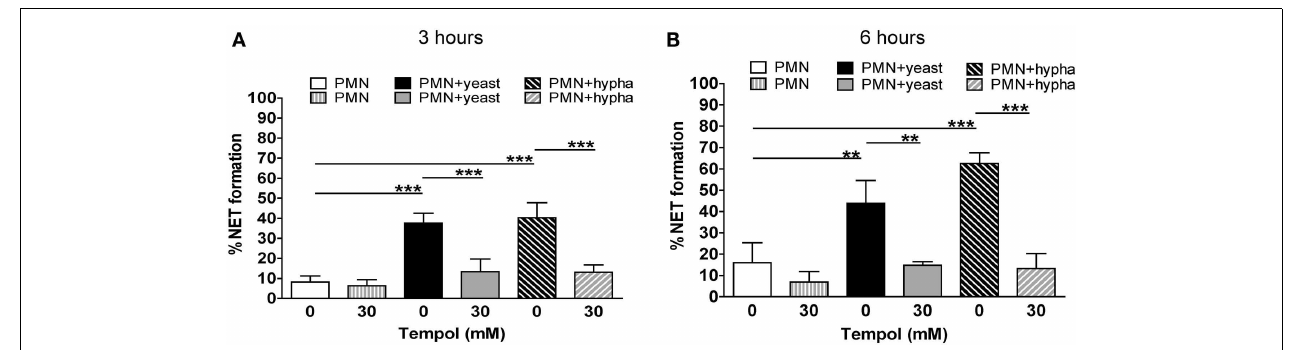
FIGURE 5 |Tempol scavenges neutrophil ROS triggered by different growth forms of C. albicans . The total amount of ROS generated by PMNs is plotted against increasing concentrations of Tempol present in the culture medium. PMNs were infected with C. albicans (MOI 3) in the presence of different concentrations ofTempol. The total amount of ROS produced over 3h was calculated as area under the curve (AUC). PMNs infected with of C. albicans yeast (A)